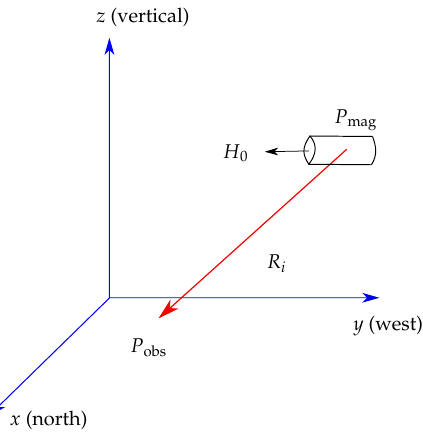
Figure 1. Localization scenario of a permanent magnet with its reference coordinate